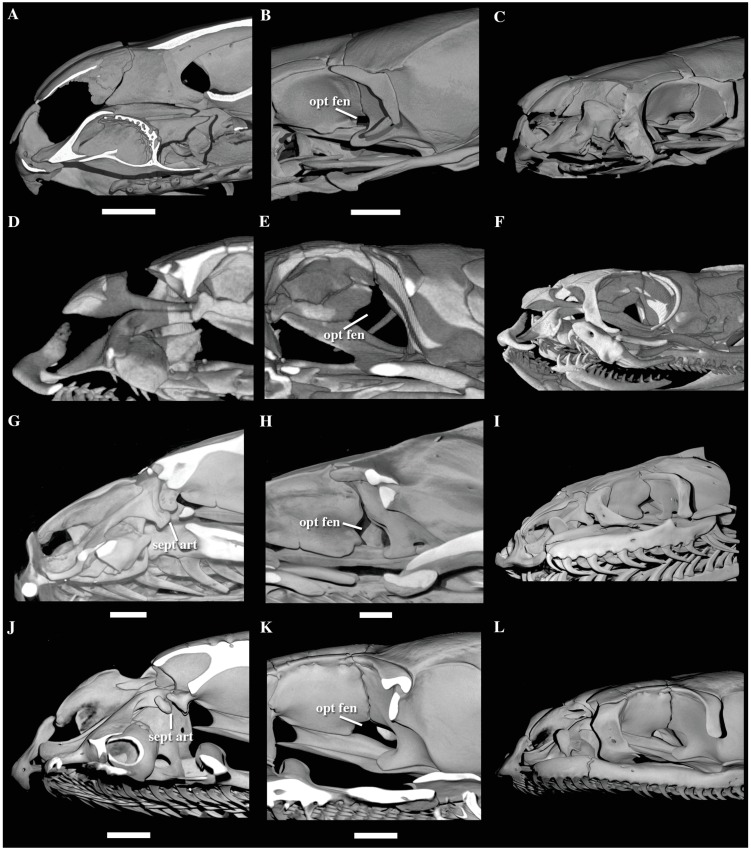
Skulls of Pareas moellendorffi (A-C),
Causus rhombeatus (D-F), Enhydris
chinensis (G-I), and Afronatrix
anoscopa (J-L).Three-dimensional surface and cutaway views based on high resolution
X-ray computed tomography. A, D, G, J left lateral three-dimensional
cutaway views along the sagittal axis; B, E, H, K, left lateral
three-dimensional surface views; C, F, I, L, oblique
three-dimensional surface views. Legends: sept. art., septomaxillary
articulation; opt. fen., optic fenestra. Scale bar = 1 mm.